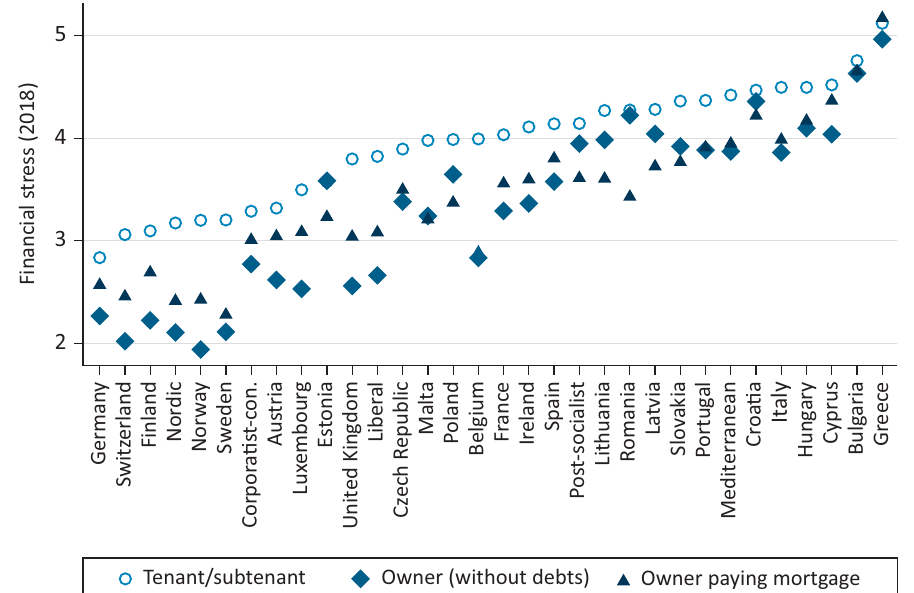
Figure 2. Difficulty in making ends meet in 2018 (averages by type of tenure). Note: The scale should be read from 6 ( with great difficulty ) to 1 ( very easily ). Source: Based on Eurostat (2021).